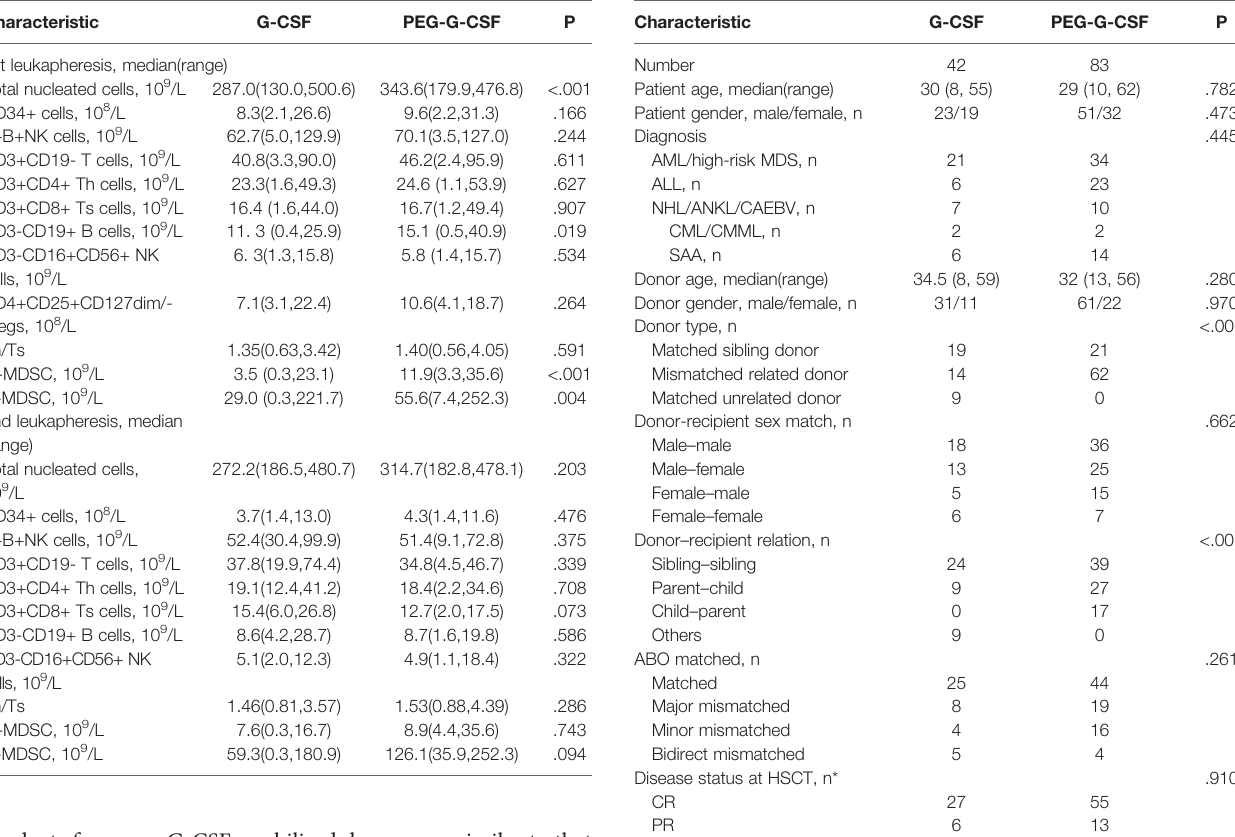
TABLE 3 | Leukapheresis Products. TABLE 4 | Recipient